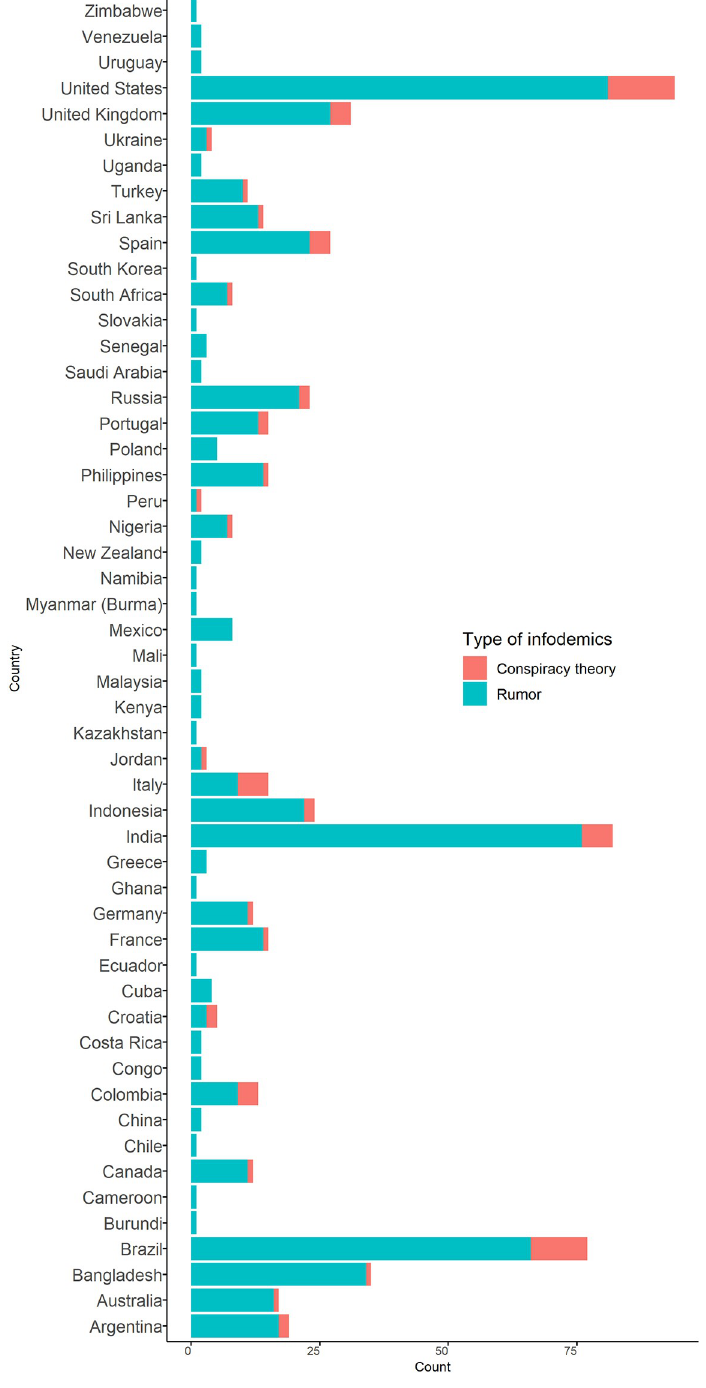
Fig 2. Rumor and conspiracy theories related to COVID-19 vaccine by country, 31 December 2019–30 November